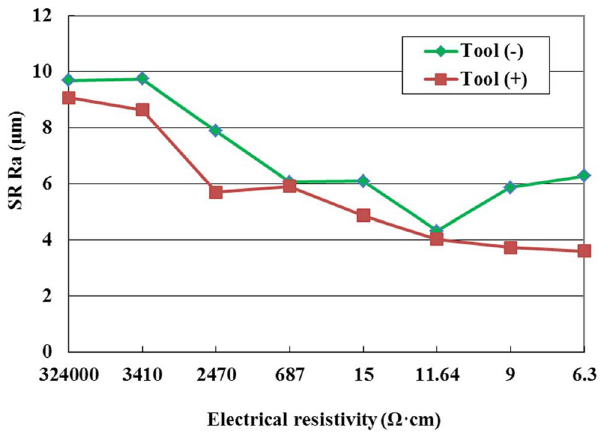
Figure 7. Effect of the tool polarity on SR.